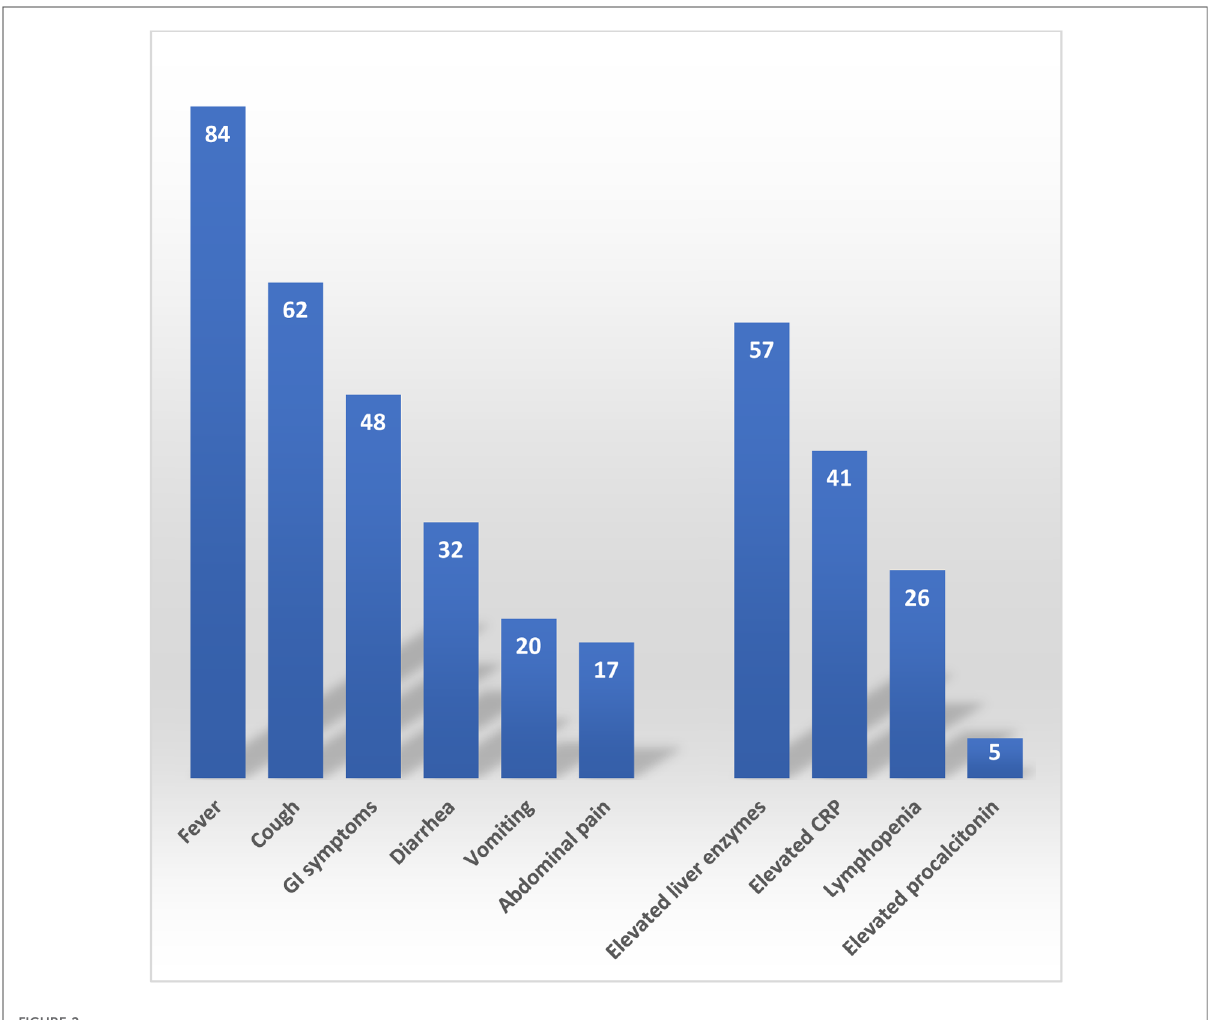
FIGURE 2 Clinical data.